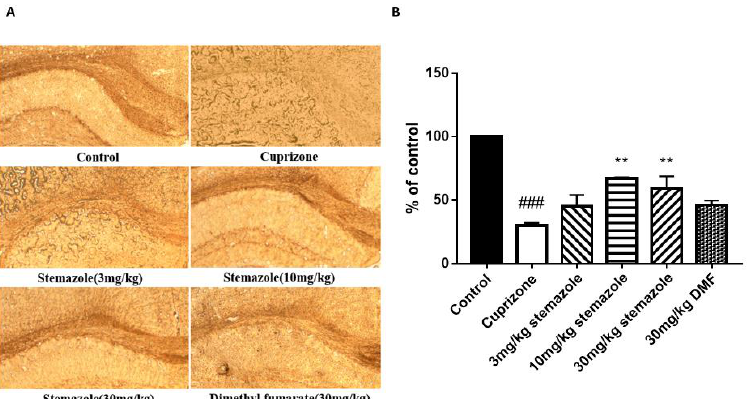
Figure 6. The protective effect of stemazole on myelin from demyelinated lesions in the corpus callosum (cc) by MBP immunohistochemistry. ( A ) MBP immunohistochemistry was used to evaluate the severity of demyelination. ( B ) MBP expression levels were compared with those of controls and expressed as a percentage of the control value using the ImageJ analysis program. Data represent the means ± SD (n = 3 duplicates). ** p < 0.01 vs. the CPZ group. ### p < 0.001 vs. control group. We also evaluated the Olig2 expression using immunofluorescence staining (Figure 7). The results indicate a significant reduction in Olig2 expression in the CPZ group com-